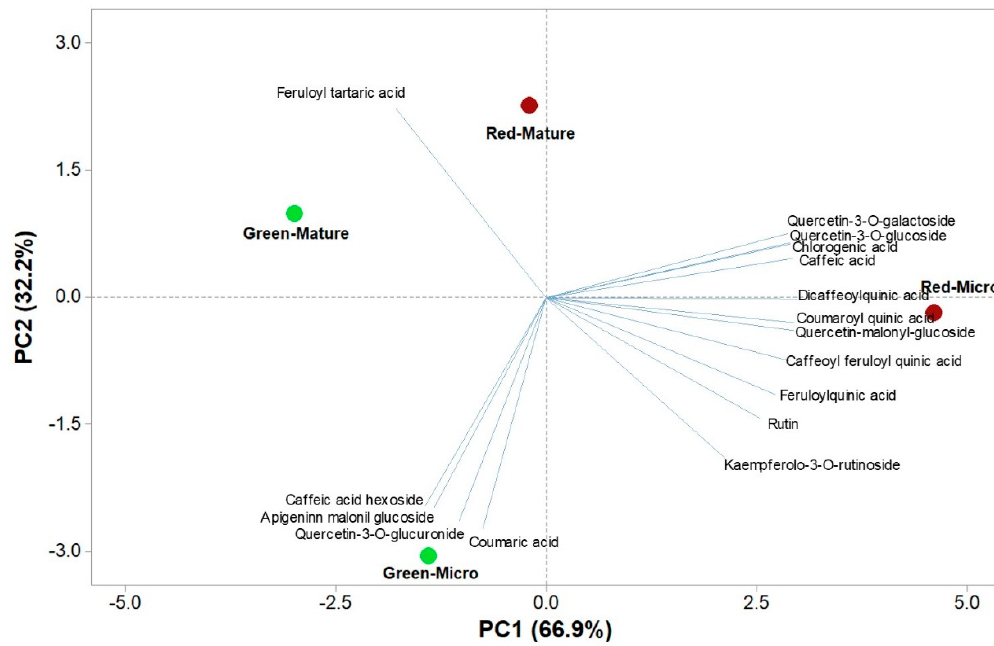
Figure 3. Principal component loading plot and scores of PCA of phenolic compounds quantified by HUPLC-Q-Orbitrap HRMS analysis in green and red microgreens and mature leaves of Salanova lettuce.